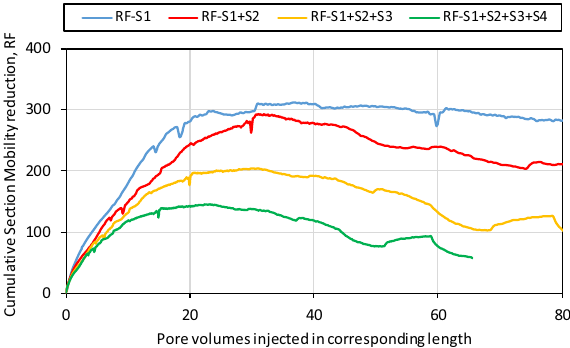
Fig. 20 Experiment 9, temperature steps, 1000 ppm A10 in 3xSSW. RF pm as a function of pore volumes injected. Volumetric injection rate is 0.6 ml/min from 198.2 PV. T = 80° to 203.9 PV. T = 60 °C from 203.9 to 240.1 PV, T = 40 °C from 240.1 to 437.6 PV, where up on temperature was lowered to 20